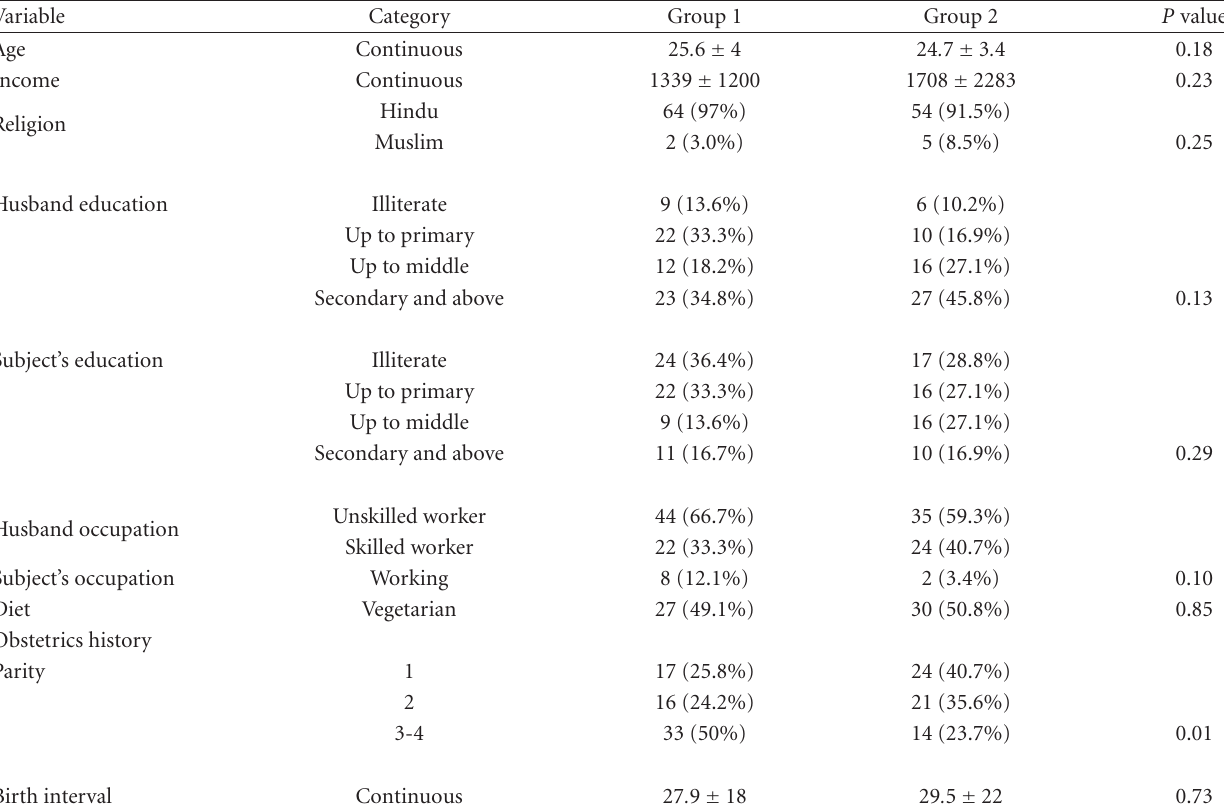
Table 1: Sociodemographic and reproductive characteristics of anemic pregnant